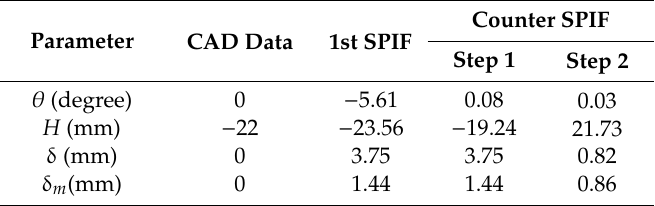
Figure 20. Results of 3D scanned results of the ship-hull shape after ( a ) the 1st and ( b ) the counter SPIF processes. Table 6. Comparison of hull shape according to each